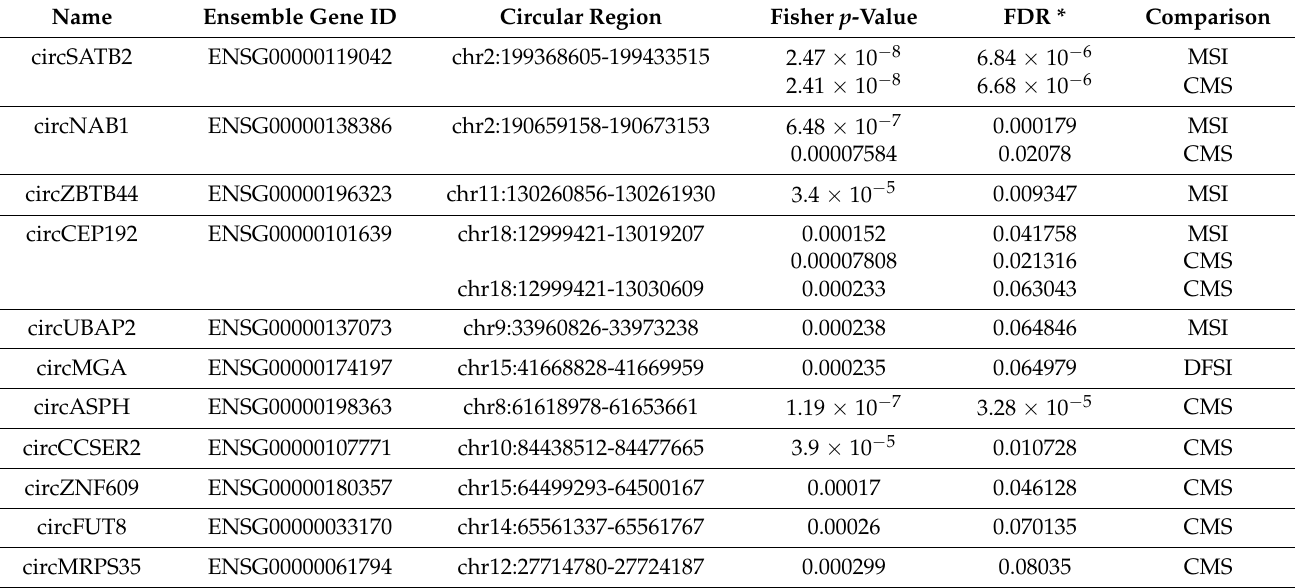
Table 3. Association of presence/absence of circRNAs with relapse status, tumor stage, CMS and